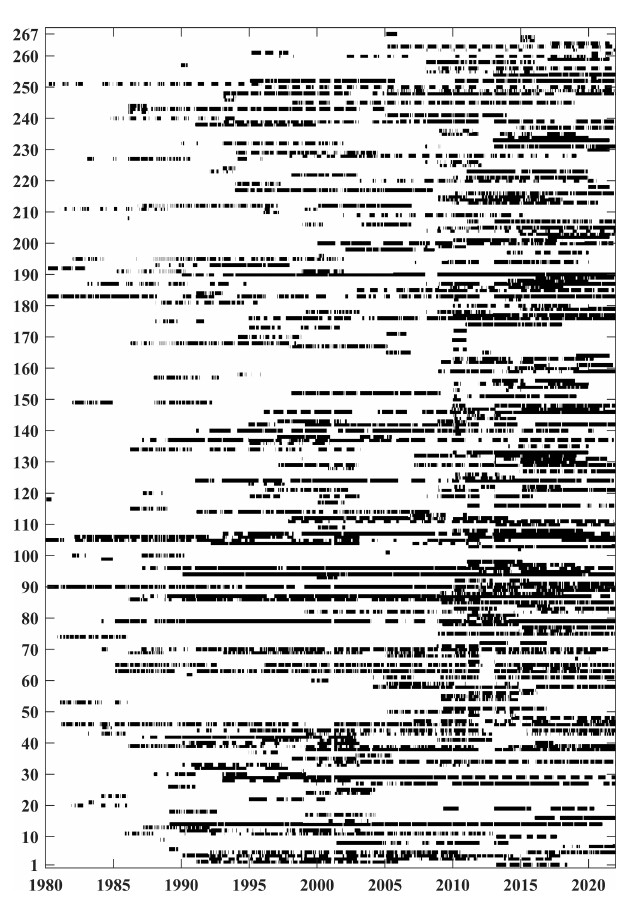
Figure 9. Daily data availability of air temperature. Missing values have no color, and 1–267 correspond to “NO.” in Table